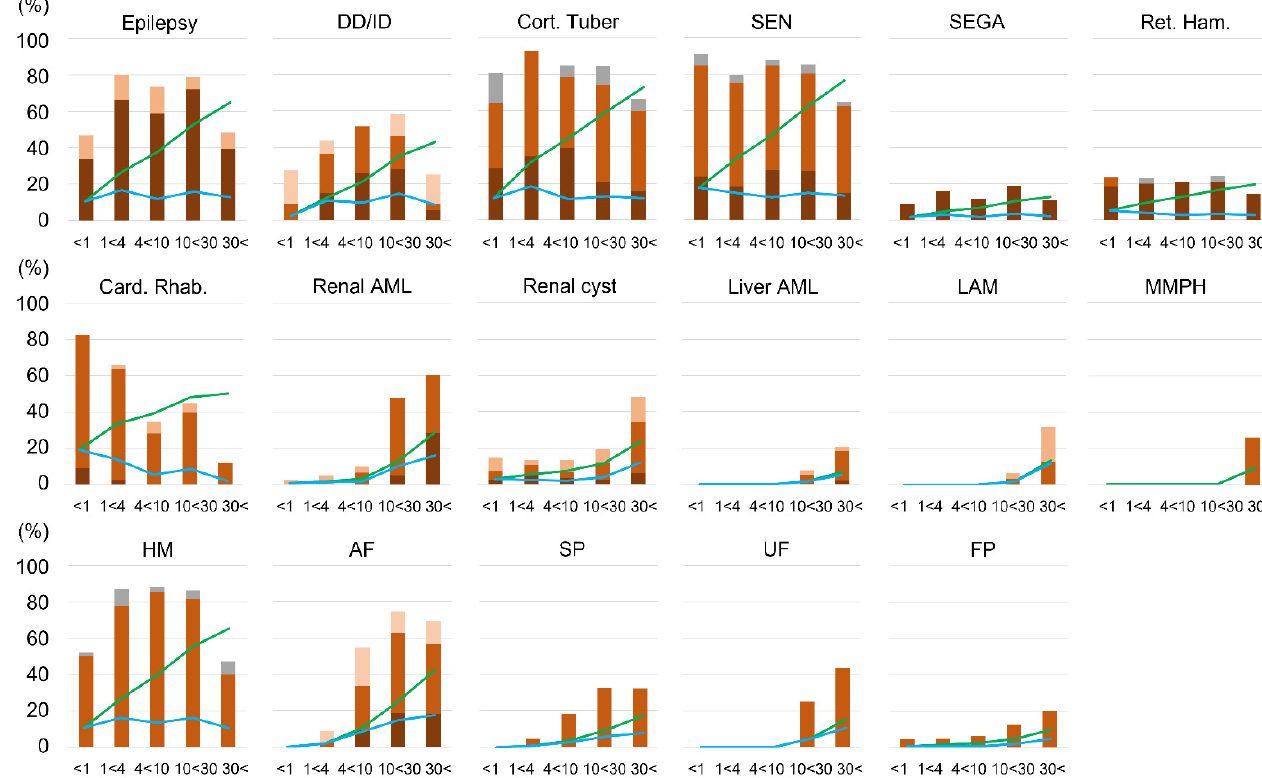
Figure 3. Frequency of each lesion and symptom in each age range of definite TSC ( n = 225). The color of each bar indicates the score in Table 13. The green line indicates the cumulative percentage, and the blue line indicates the percentage increase from previous age groups. Abbreviations are the same as in Figure 2.